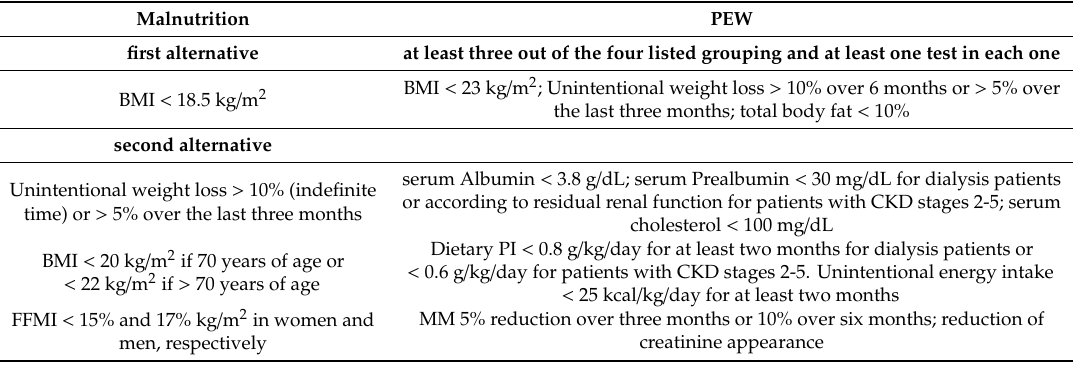
Table 1. Diagnostic criteria for malnutrition and protein-energy wasting in CKD